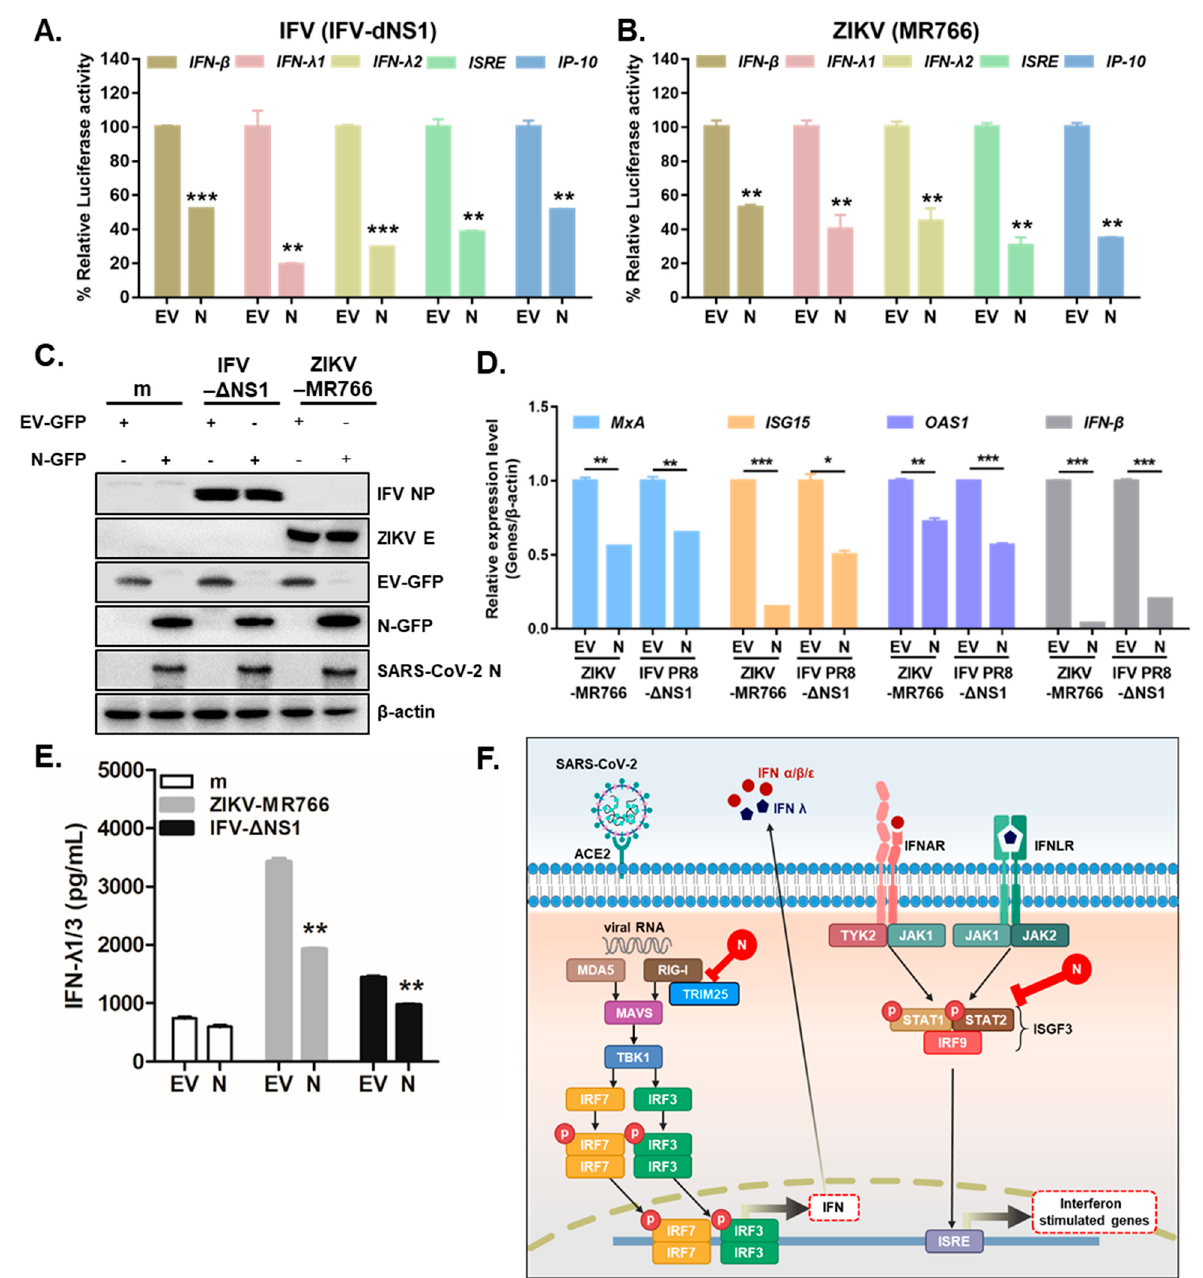
Figure 4. SARS-CoV-2 N markedly attenuates RNA virus-triggered IFN production. ( A , B ) Luciferase activities of A549 cells transfected with IFN- β , IFN- λ 1, IFN- λ 2, ISRE, and IP-10 promoter luciferase plasmids together with expression vector for RIG-I, along with 100 ng of EV-GFP (EV) or SARS-CoV-2 N-GFP (N) expression plasmids. At 24 h after transfection, the cells were infected with IFV-delNS1 (IFV-dNS1) (A) or ZIKV (MR766) ( B) at multiplicity of infection (MOI) = 1 for 6 h (mean ± SD, n = 3). ** p < 0.01; *** p < 0.001 versus EV-GFP-transfected cells. ( C ) A549 cells were transiently transfected with EV-GFP or SARS-CoV-2 N-GFP expression plasmids. After 24 h, cells were infected with mock (m), ZIKV (MR766), or IFV-delNS1 (MOI = 1). ( D ) RT-qPCR reveals mRNA levels of MxA, IFN- β , ISG15 , and OAS1 following viral infection. * p < 0.05; ** p < 0.01; *** p < 0.001 versus EV-GFP-transfected cells. ( E ) IFN- λ 1/3 secretion levels were measured by ELISA assays. ** p < 0.01 versus EV-GFP-transfected cells. ( F ) Schematic representation of how SARS-CoV-2 N protein interferes with IFN induction and signaling.